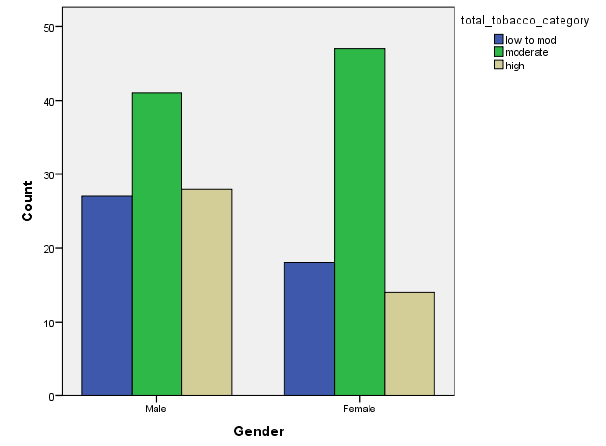
Figure 3. Frequency of tobacco and alcohol consumption depending on gender (male).